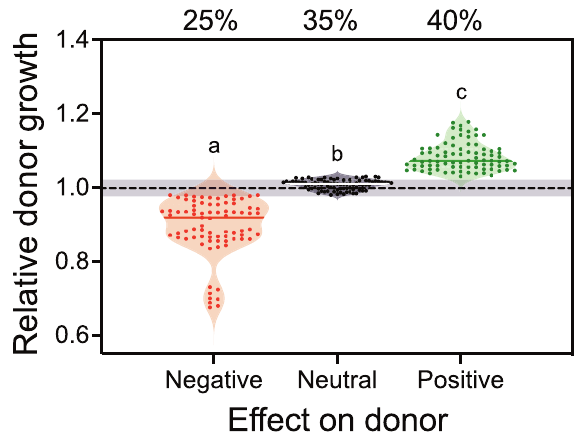
Fig. 2 Prototrophic donor cells commonly bene fi t from the presence of auxotrophic recipients. The growth of donor cells in coculture with auxotrophic recipients is plotted relative to their growth in monocultures. The dashed line corresponds to the growth of donors in monocultures ( = 1). Values were categorised based on the threshold above (±1.02) and below (±0.98) which donors experience a growth advantage or disadvantage, respectively, in coculture with the recipient (i.e. grey-shaded area). Depending on whether the donor ’ s growth deceeded or exceeded the threshold, interactions were classi fi ed as negative (red, n = 60), neutral (black, n = 84), or positive (green, n = 96). Data points represent replicates and show cumulative results of all comparisons (i.e. two auxotro- phies ( Δ hisD and Δ trpB) per two species ( A. baylyi and E. coli )). Violins display the shape and horizontal lines within data points the median of the distribution. Different letters indicate signi fi cant differences between groups (Dunn ’ s post hoc test: P < 10 − 4 , n =